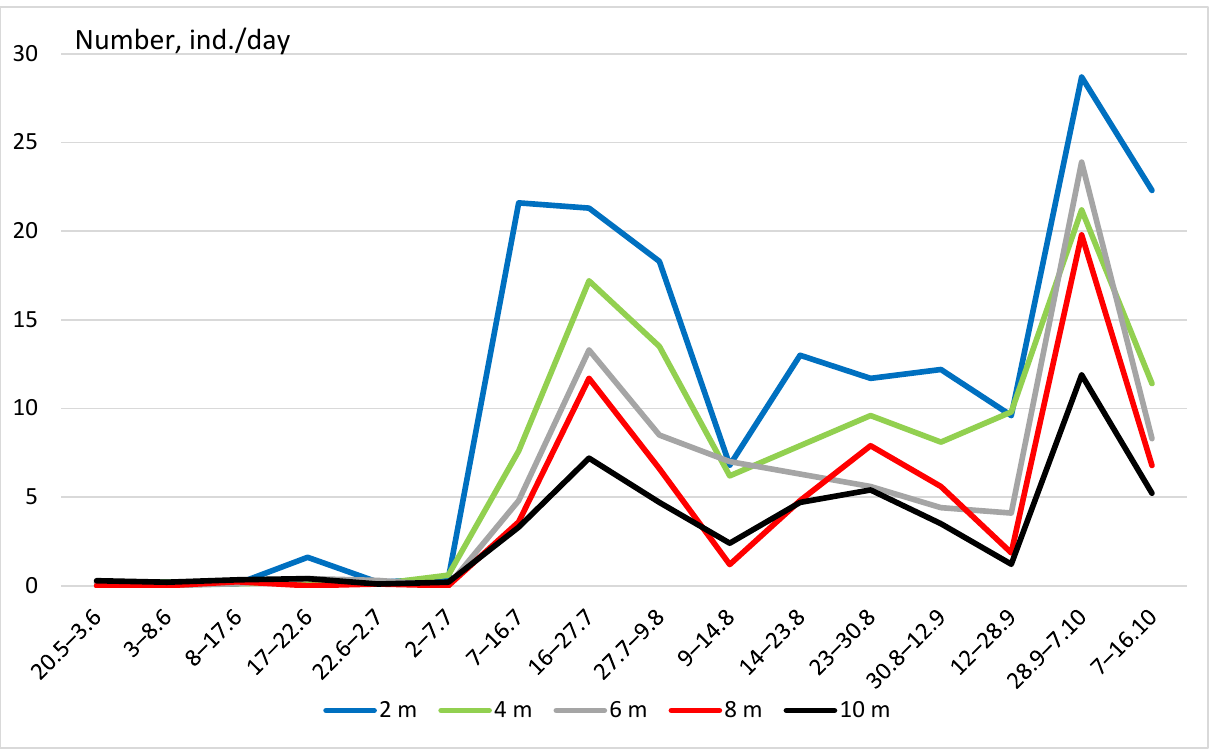
Figure 7. Seasonal dynamics of Lepidoptera abundance at various heights on forest glades in 2020.